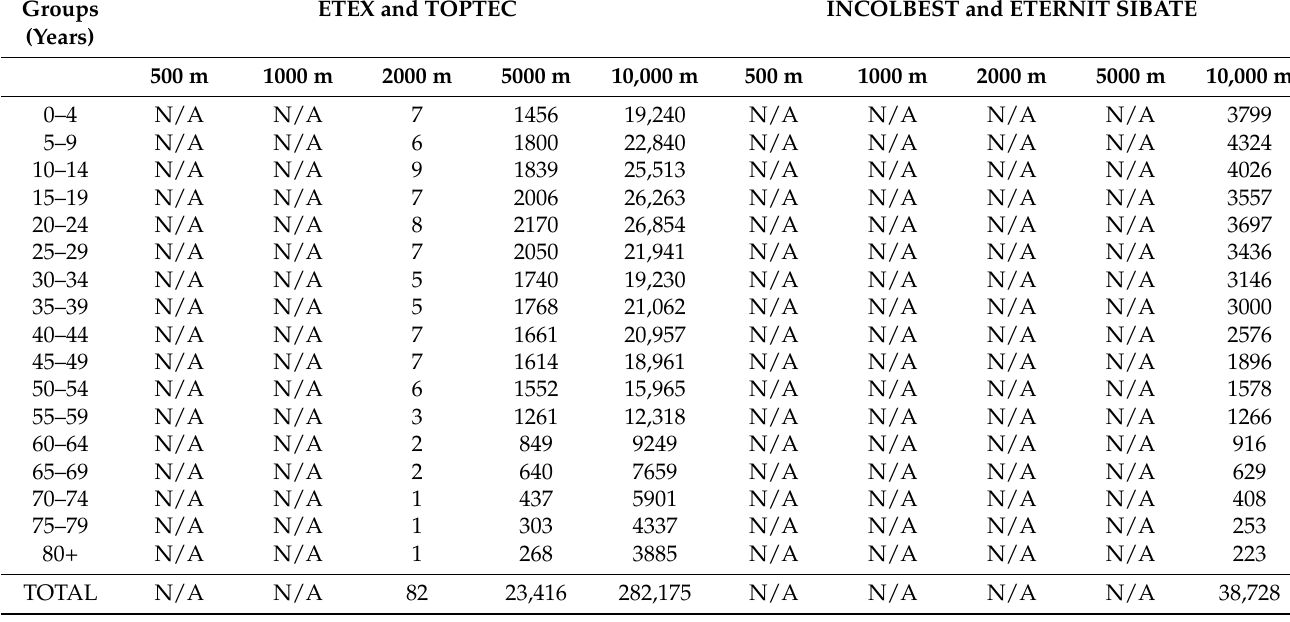
Table 5. Populations living in the vicinity of two plants in 2005 (Etex and Toptec—Manizales; Incolbest—Bogot á and Eternit—Sibat é ).